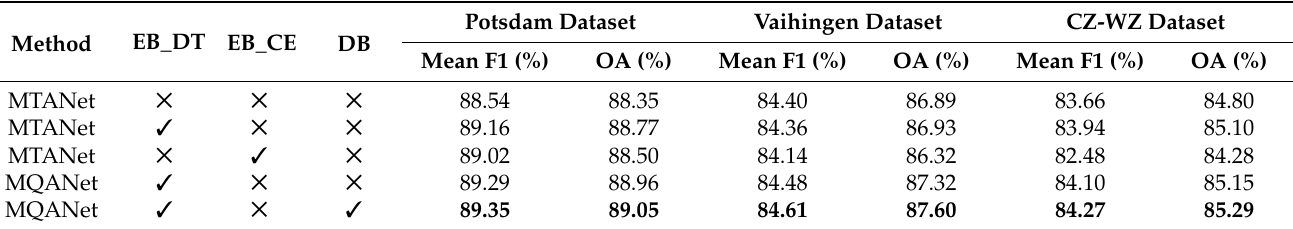
Table 7. Mean F1 and OA index results on edge optimization.